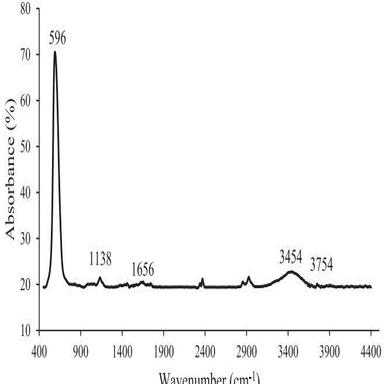
FTIR spectrum for the as-synthesized mesoporous alumina.